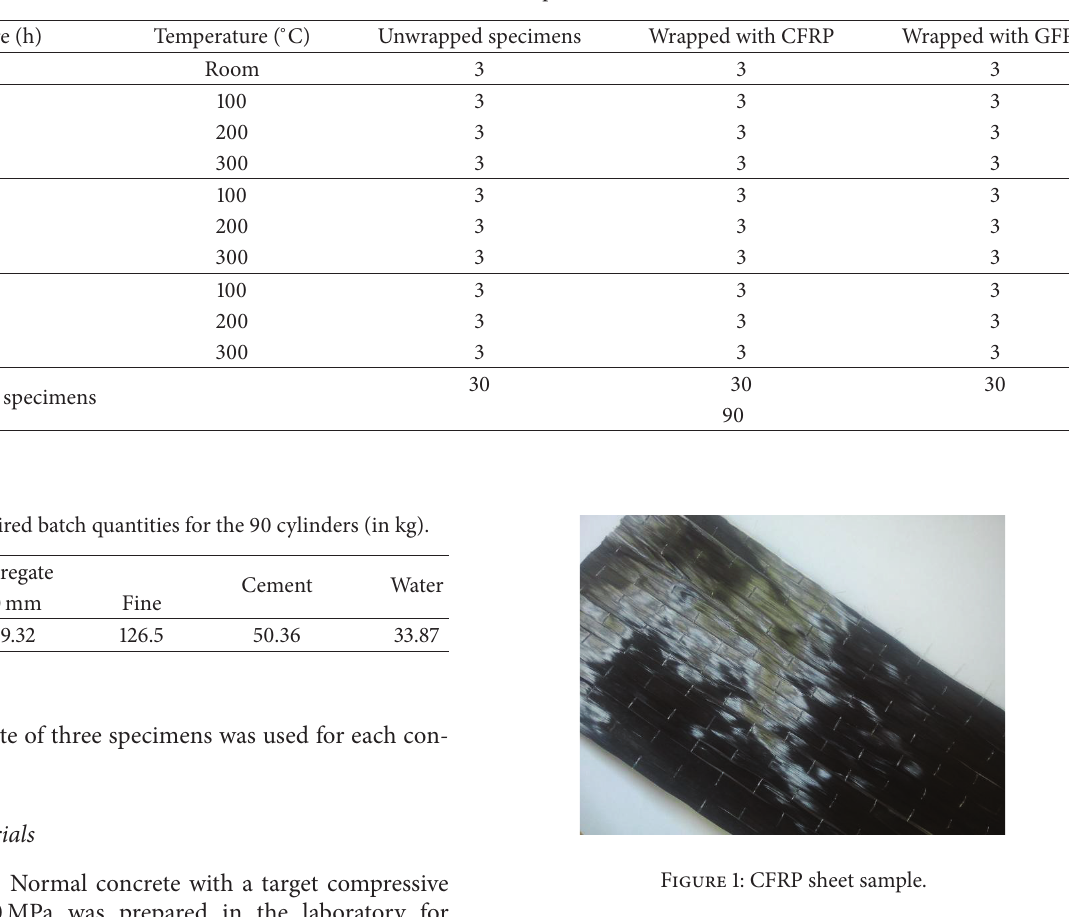
Table 1: Schedule of test specimens.